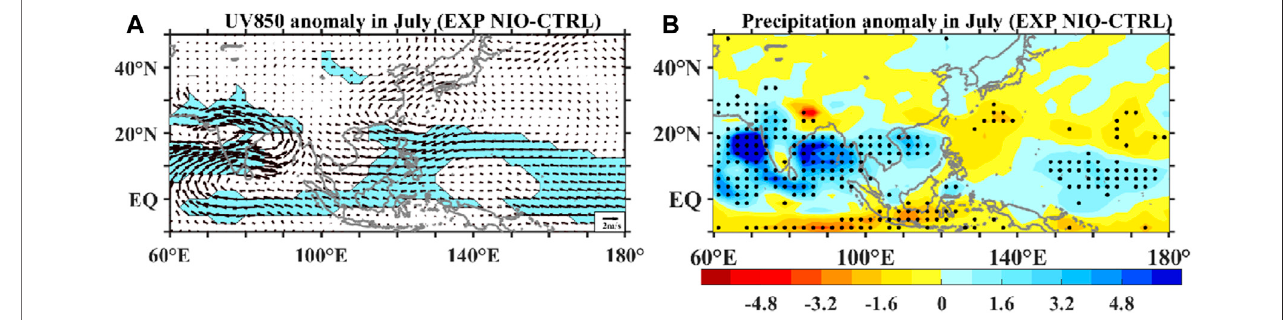
FIGURE 8 | (A) 850-hPa horizontal wind anomaly (units: m/s) and (B) precipitation anomaly (units: mm/day) in July during 1971 – 2000 from EXP NIO-CTRL. Shaded (a) and dotted (b) areas indicate statistical signi fi cance at the 95% level, as estimated by a Student ’ s t -test.